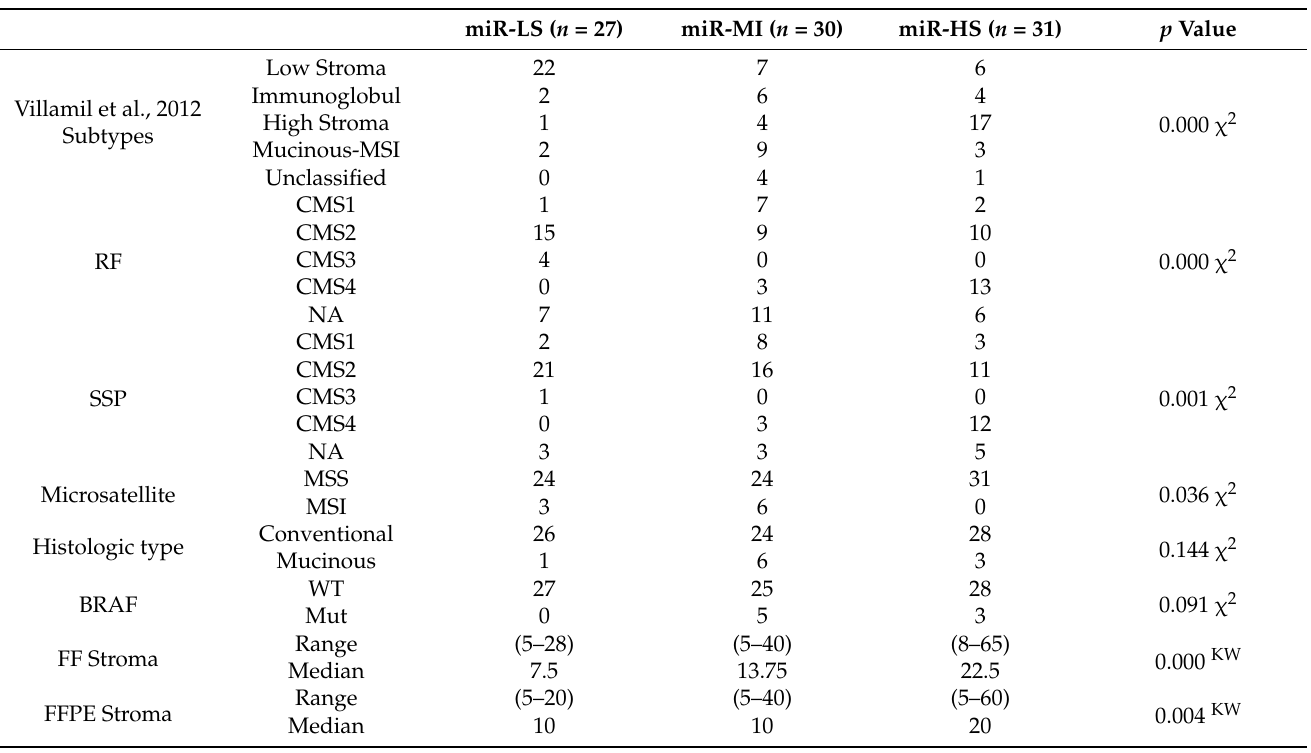
Table 1. Association of miRNA clusters to Villamil et al. subtypes, to CMS and to clinic-biological